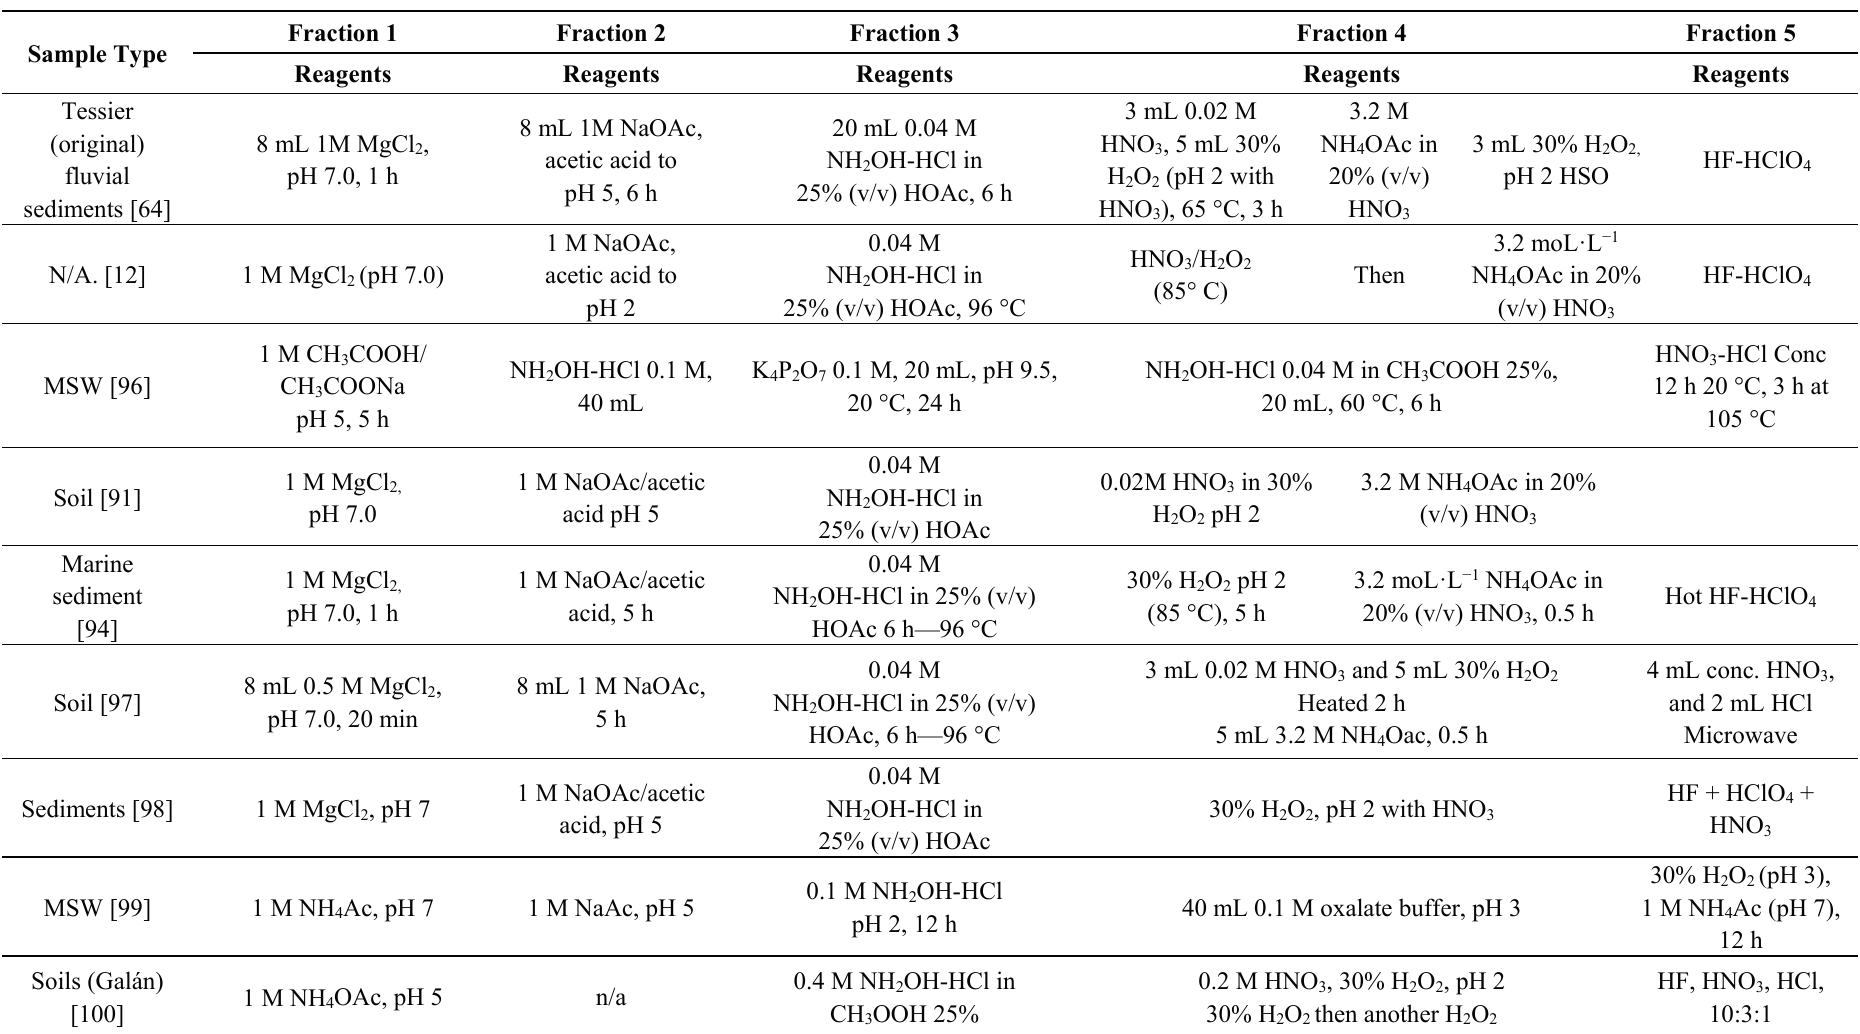
Table 5. Modifications of Tessier sequential extraction procedure